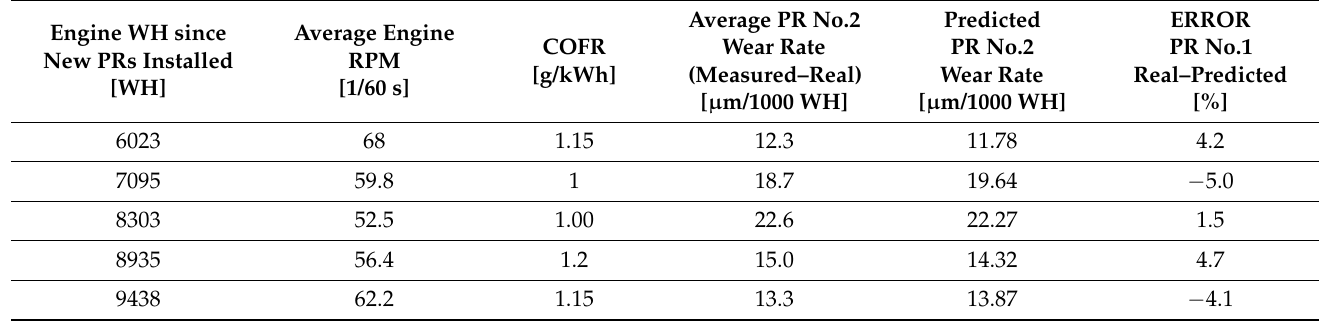
Table 5. Results of the PR wear ratio prediction model verification obtained for PR No.2.